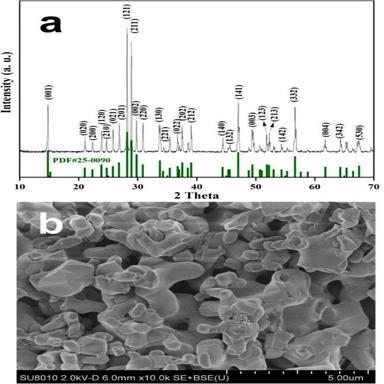
Micro-BFO obtained by solid state method: (a) XRD pattern and (b) SEM.